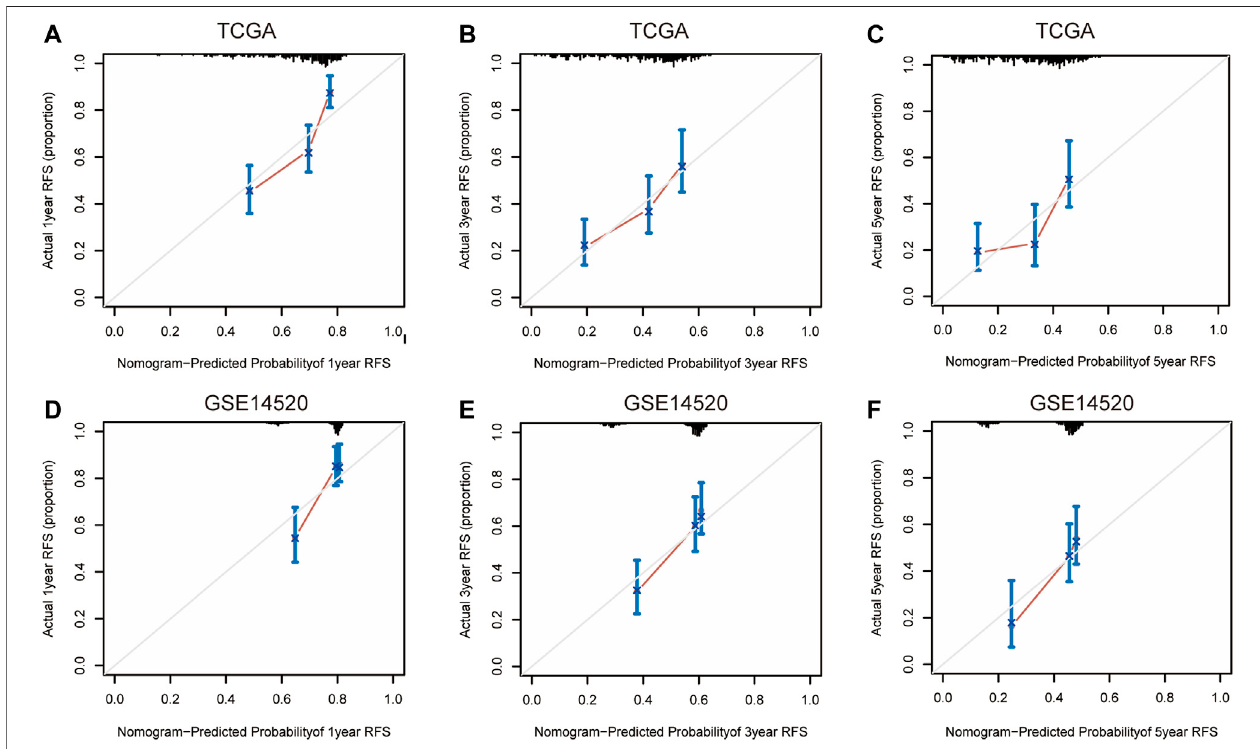
FIGURE 10 | 1-year, 3-year, and 5-year calibration curves of the nomogram model in TCGA (A – C) and GSE14520 (D – F) RFS dataset. Notes: TCGA, The Cancer Genome Atlas Program; ICGC, International Cancer Genome Consortium; RFS, recurrence-free survival.